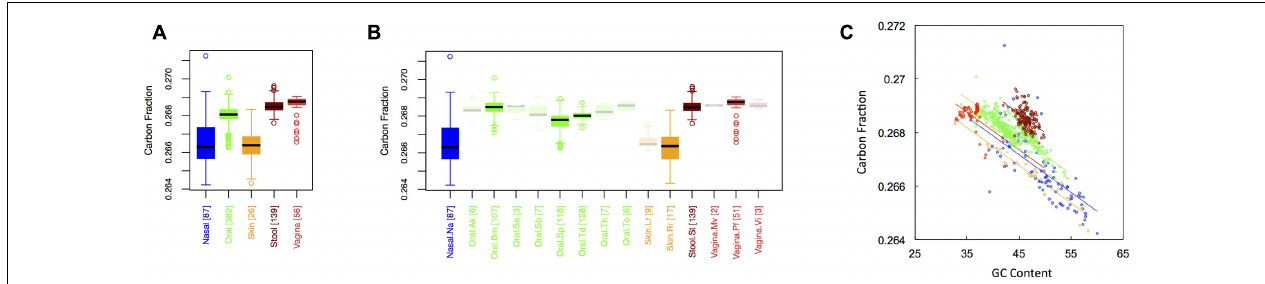
FIGURE 1 | Boxplots showing the average carbon content of microbial proteins as a function of human body site for (A) the 5 major sites and (B) the 15 minor sites in our study. The number of samples from each site is indicated in square brackets on axis labels. Faded boxes are used for sites with fewer than 10 samples. Differences in carbon content were tested with Dunn’s test. Statistics are summarized in Appendix II, Tables A.2.1, A.2.2; (C) Scatterplot of carbon content versus GC content with associated regression lines from our ANCOVA analysis for major body sites: nasal (blue), oral (green), skin (yellow), stool (brown), and vaginal (red).